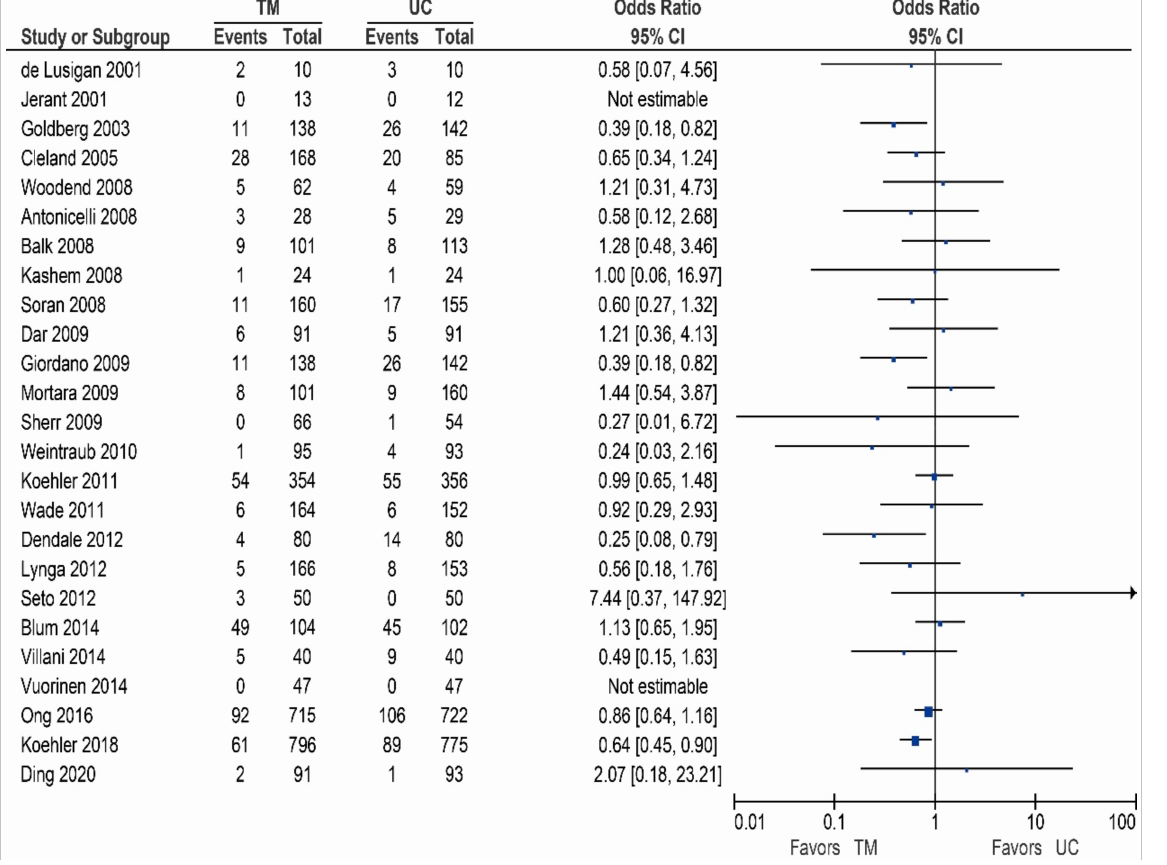
Figure 4. All-cause mortality in patients receiving non-invasive telemonitroing versus usual